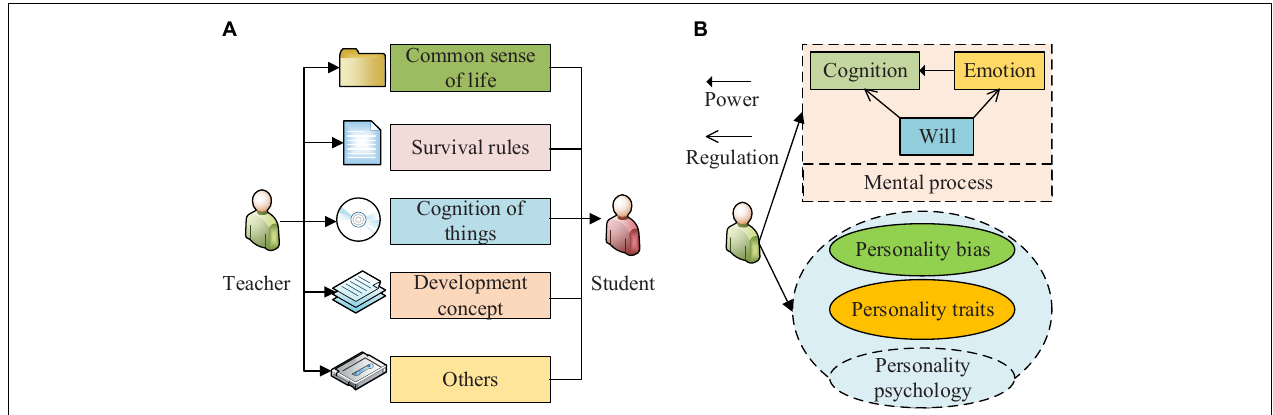
FIGURE 1 | The main content and characteristics of Educational Psychology (EPSY). (A) The main content and characteristics of pedagogy, (B) The main content and characteristics of psychology.